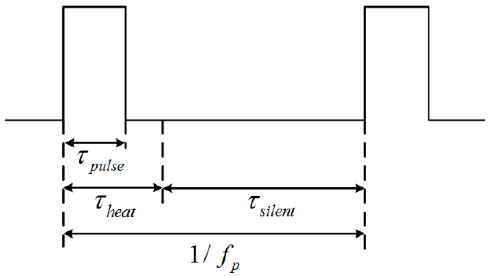
Figure 17. Time series diagram of NS-DBD discharge.